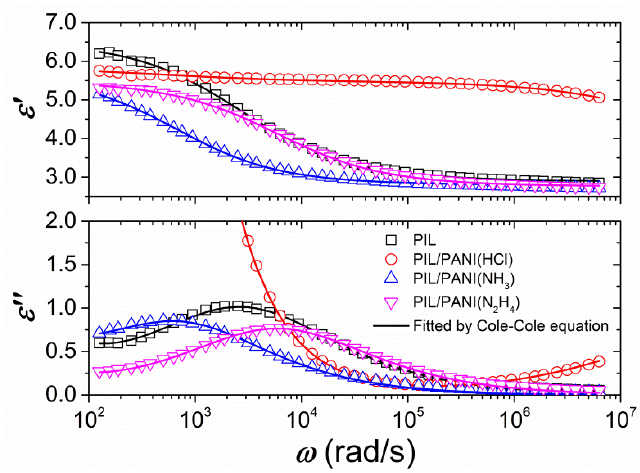
Figure 9. Dielectric relaxation spectra of the ER fluids ( T = 30 °C). Solid lines show the best fit of ε ′ and ε ″ by Equations (2) and (3).